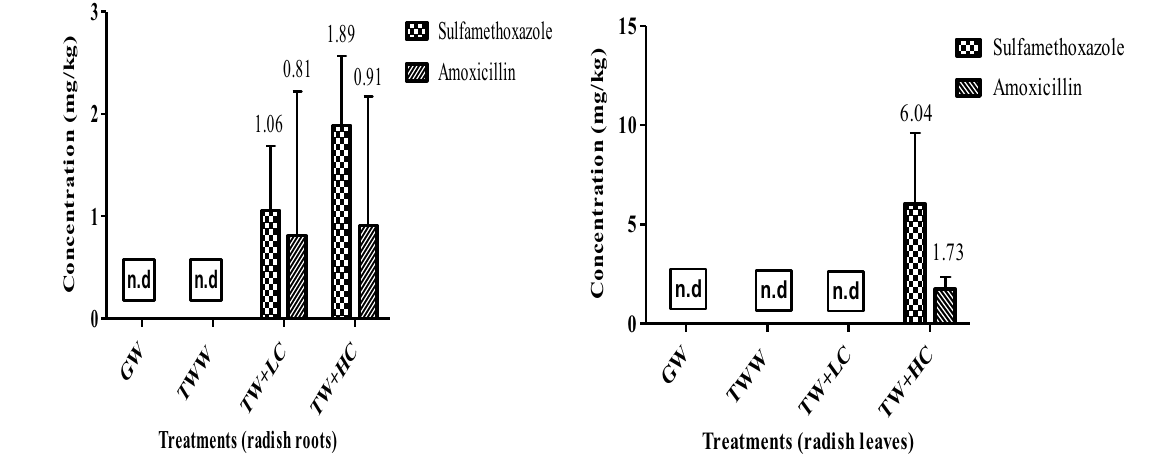
Fig. 3 Detected concentrations of pharmaceuticals accumulated in radish roots and that were translocated to the radish leaves (n.d: not detected), the results were calculated for three replicate samples and presented as mean values, GW: groundwater, TWW: treated waste-